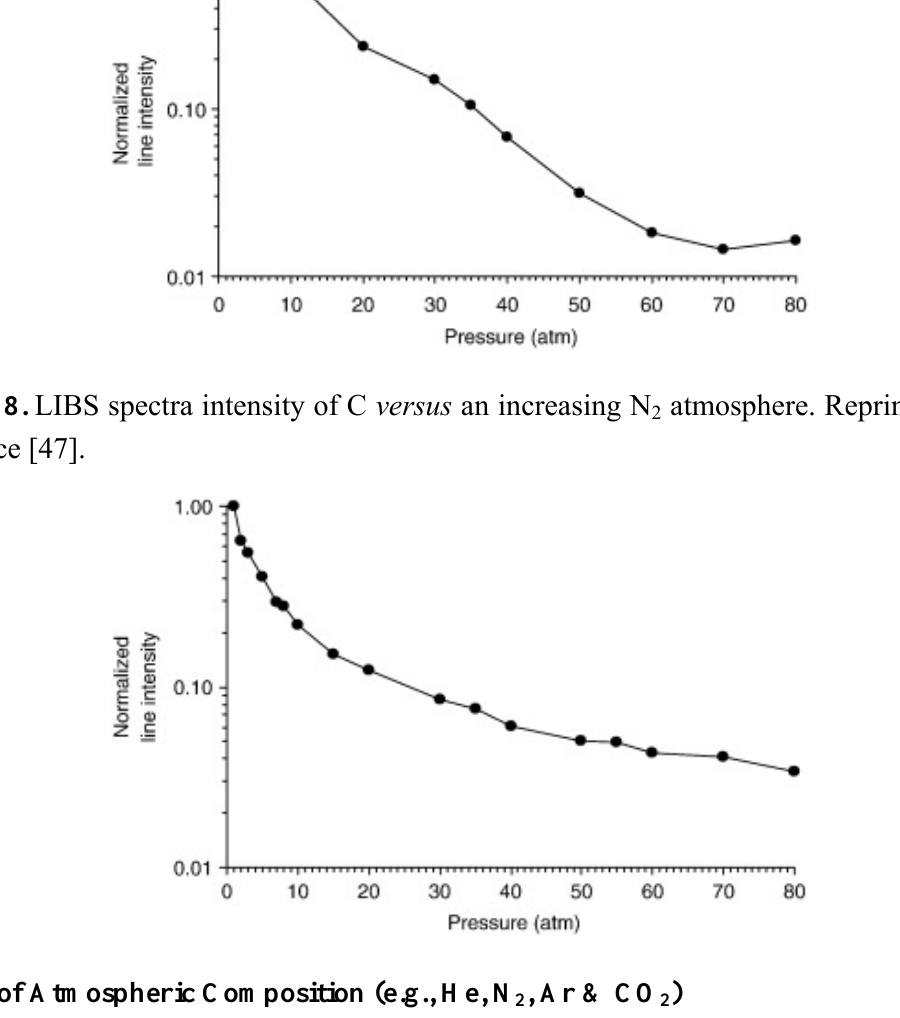
Figure 7. LIBS spectra intensity of C versus an increasing He atmosphere. Reprinted from reference [47].